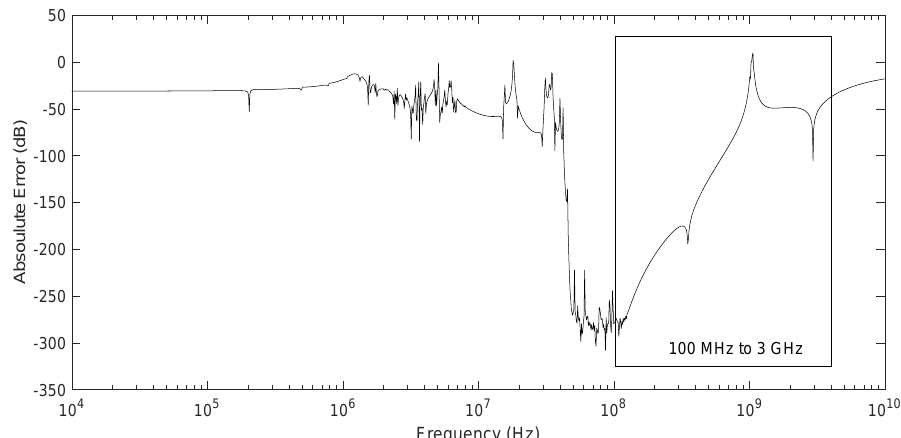
Figure 14. Absolute error of ROM generated using RNSZ of order N = 38 compared to original system frequency response of a spiral inductor (order n = 191). The mean absolute error is − 129.98 dB from 100 MHz to 3 GHz frequencies.